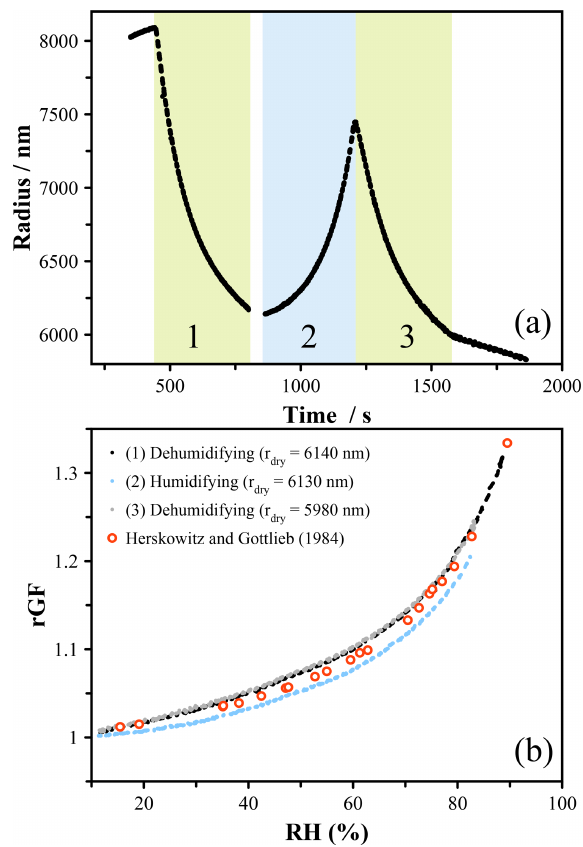
Figure 7. (a) Radial evolution of a tetra-ethylene glycol droplet ex- posed to a rapid pseudo-continuous RH profile. The vapor pressure ( ∼ 16.9mPa) results in relatively fast evaporation under low-RH conditions, leading to difficulties in defining the dry size. (b) The hygroscopicity was determined with an updated dry size for each humidifying and dehumidifying cycle. The data are compared to the literature measurements of Herskowitz and Gottlieb (1985) (using an isopiestic method; Rard,